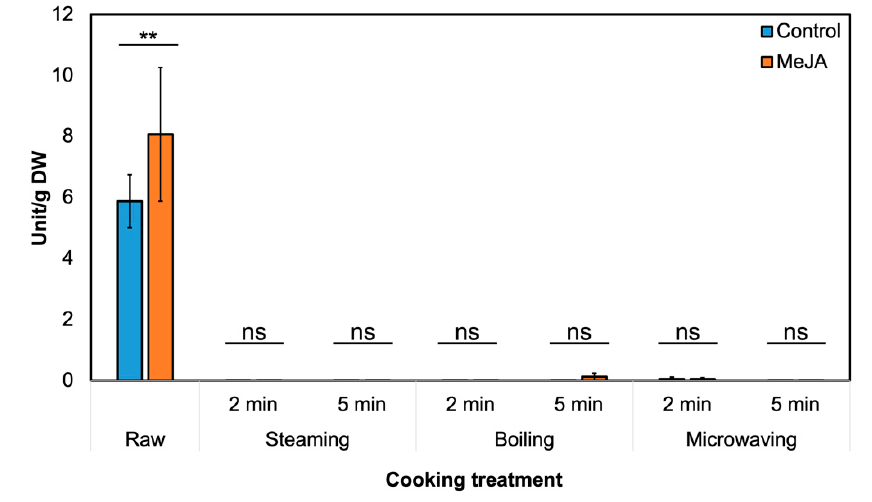
Figure 3. Effect of cooking and 250 µM MeJA treatment on myrosinase activity in broccoli. Asterisk (*) = detected E ff ect of cooking and 250 µ M MeJA treatment on myrosinase activity in broccoli. significant difference with MeJA treatment by Student’s T -test at p ≤ 0.05 ( n = 3). One unit = 1 µmole of total Asterisk (*) = detected significant di ff erence with MeJA treatment by Student’s T-test at p ≤ 0.05 released GSL hydrolysis products in 1 minute. ns , not significant; **, p ≤ 0.01. ( n = 3). One unit = 1 µ mole of total released GSL hydrolysis products in 1 minute. ns , not significant; **, p ≤